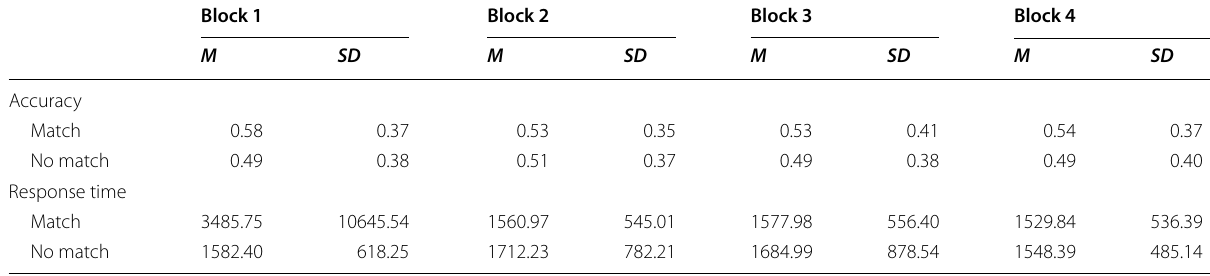
Table 6 Prospective memory accuracy and response time across blocks in the prior experience in Experiment 2 Block